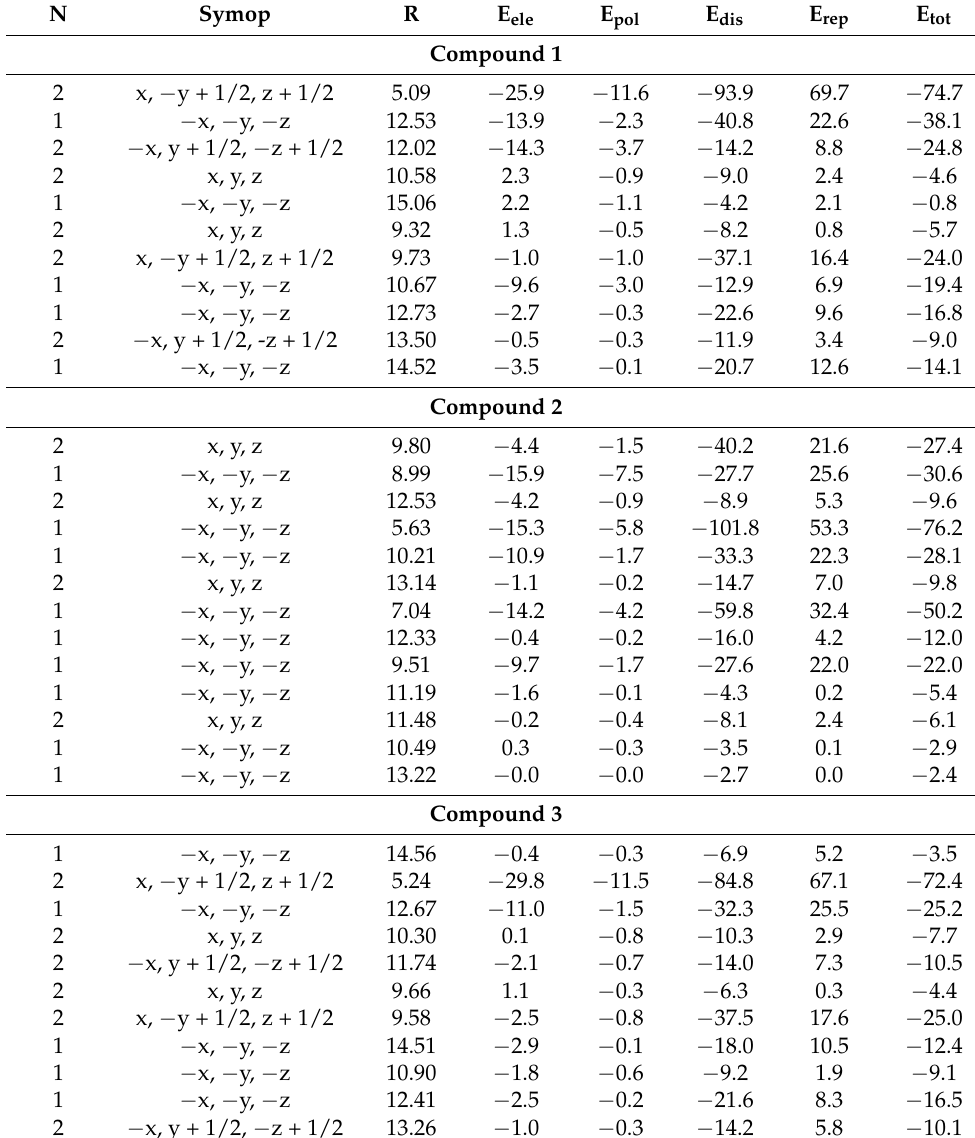
Table 3. Selected CrystalExplorer CE-B3LYP interaction energies (kJ/mol) for compounds 1 , 2 and 3 . N is the number of molecules with a molecular centroid-to-centroid distance R (Å). Electron density was calculated using B3LYP/6-31G(d,p) model energies. Symop is the symmetry operation.